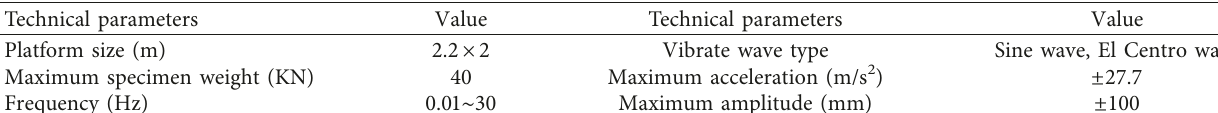
Figure 3: Shaking table system. (a) Shaking table surface. (b) Dynamic system of shaking table. Table 1: Technical parameters of shaking table.